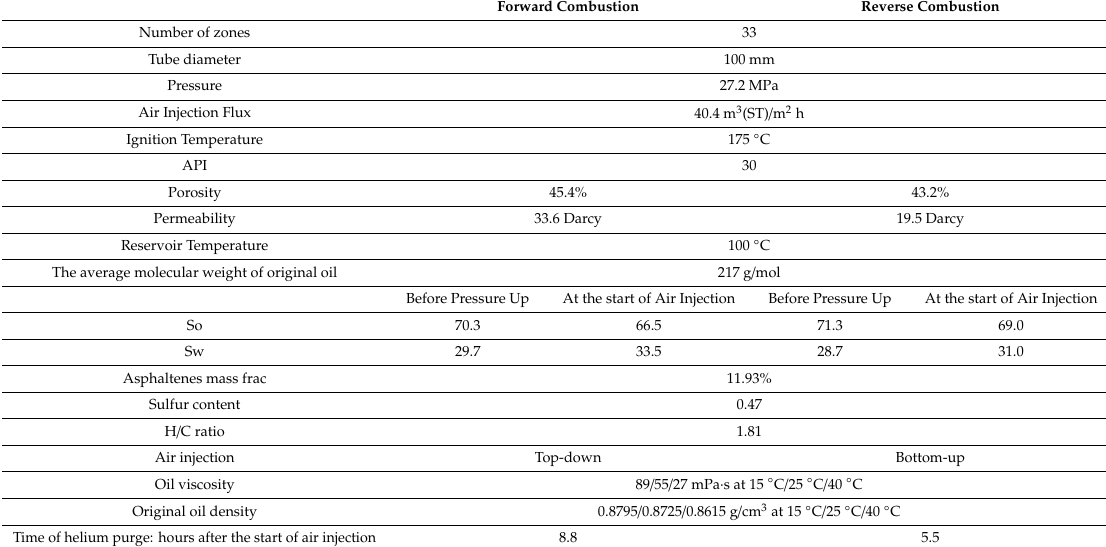
Figure 1. High-Pressure Combustion Tube experimental setup. Table 1. HPCT tests input